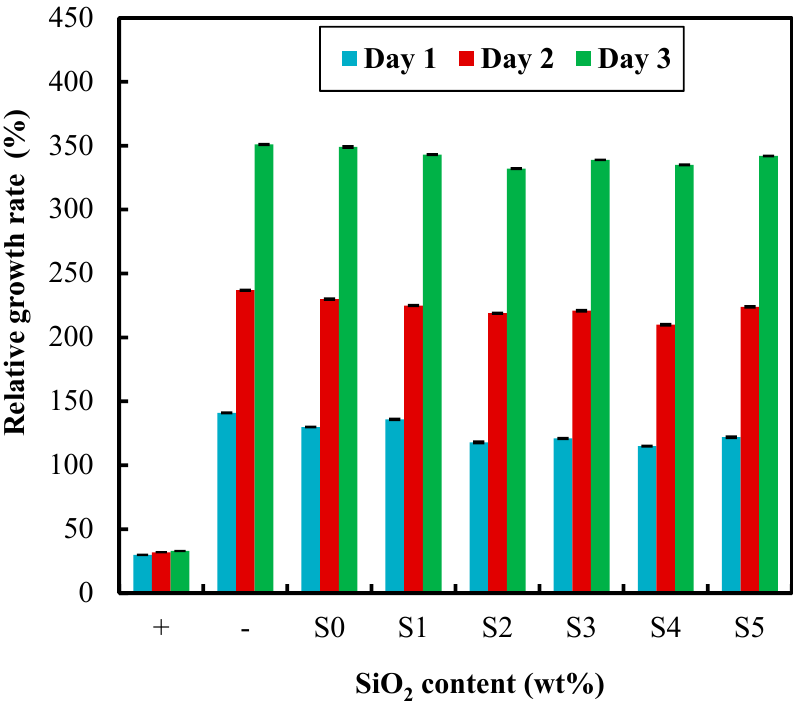
Figure 8. E ff ect of SNPs content on cytotoxicity. Figure 8. Effect of SNPs content on cytotoxicity.